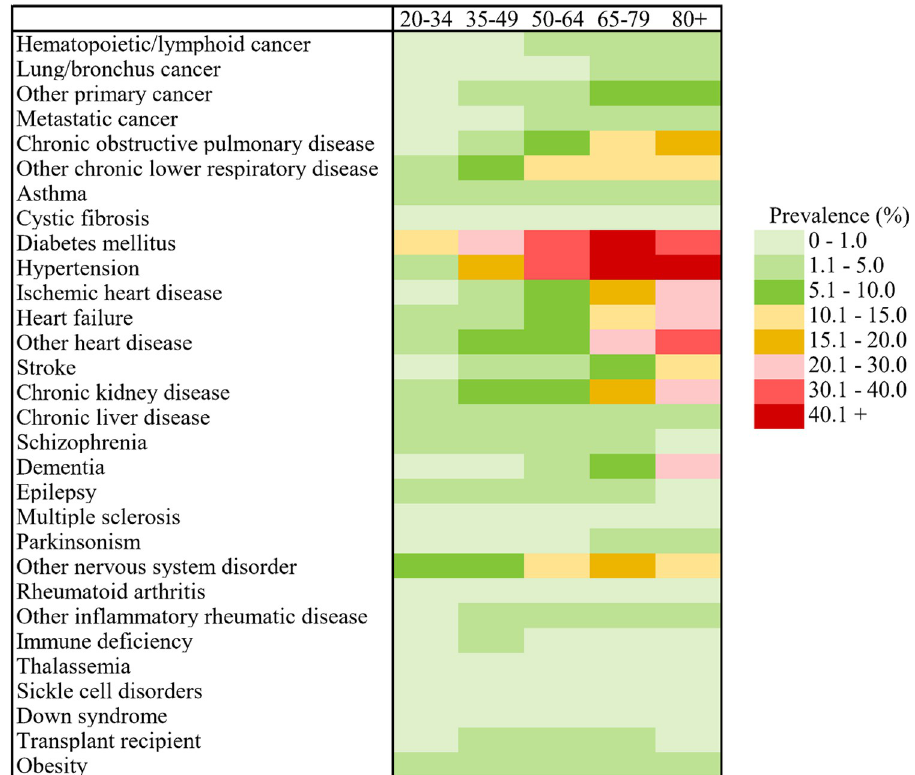
Fig 1. Prevalence (%) of chronic conditions among adults (aged 20+ years) during first acute care hospitalizations with a confirmed or suspected COVID-19 diagnosis in Canada by life-course age group. Includes acute care hospitalizations ending by March 31, 2021 in Canada, excluding Quebec. For detailed estimates see Table 2. COVID- 19 = coronavirus disease